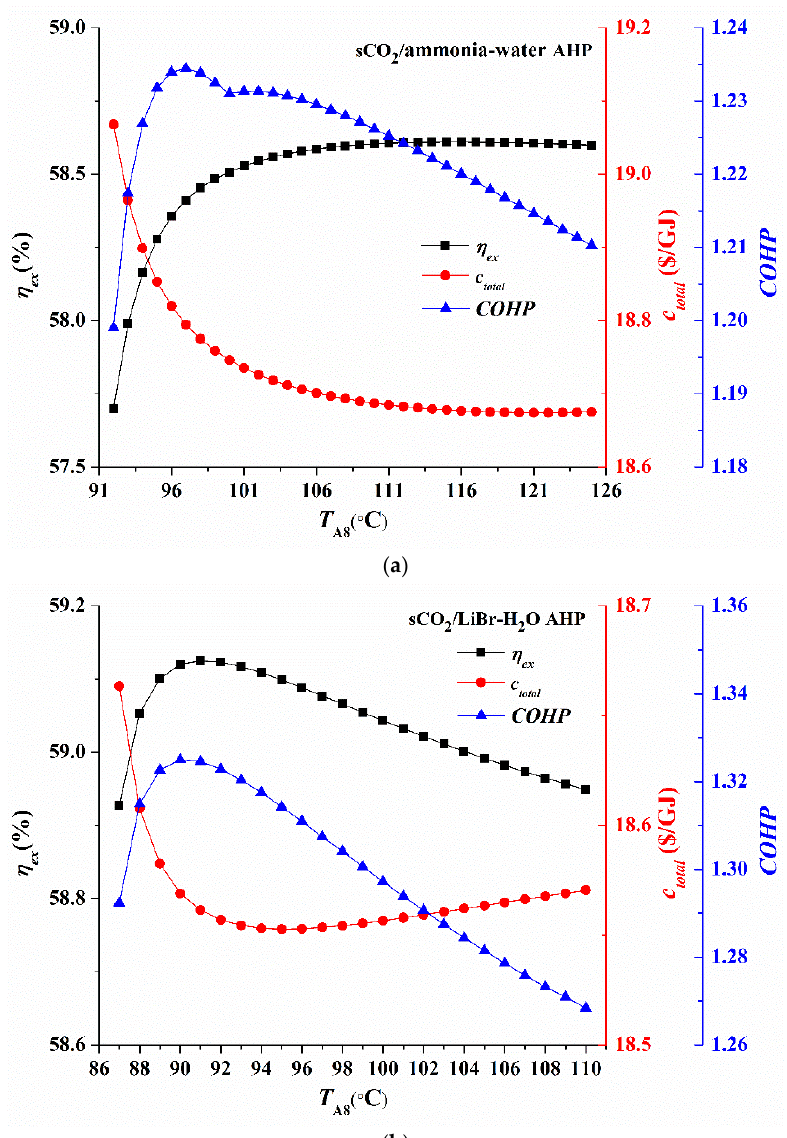
Figure 6. Variation trends of η ex , c total and COHP with T A8 : ( a ) sCO 2 /ammonia-water AHP system; ( b ) sCO 2 /LiBr-H 2 O AHP system.